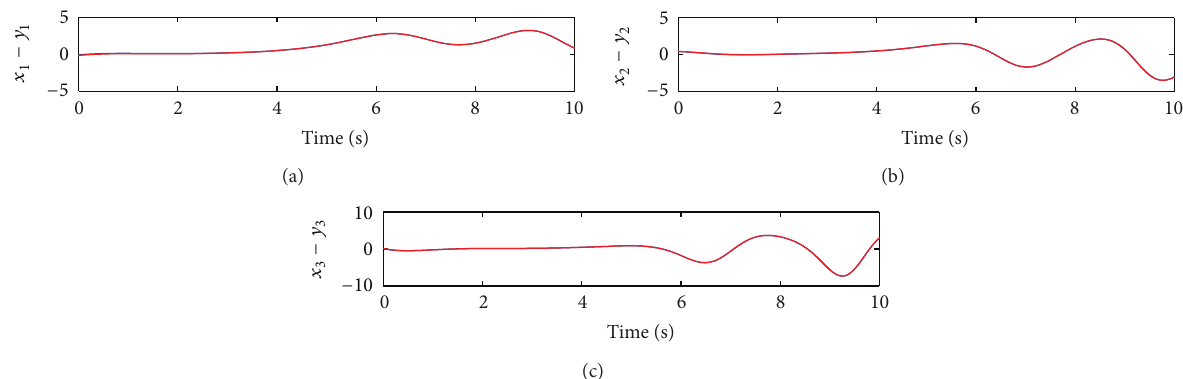
Figure 1: Synchronization of the fractional Arneodo system and the fractional Genesio-Tesi system with the control input (27) (red line represents the trajectories of the drive system, while blue line represents the trajectories of the response system).